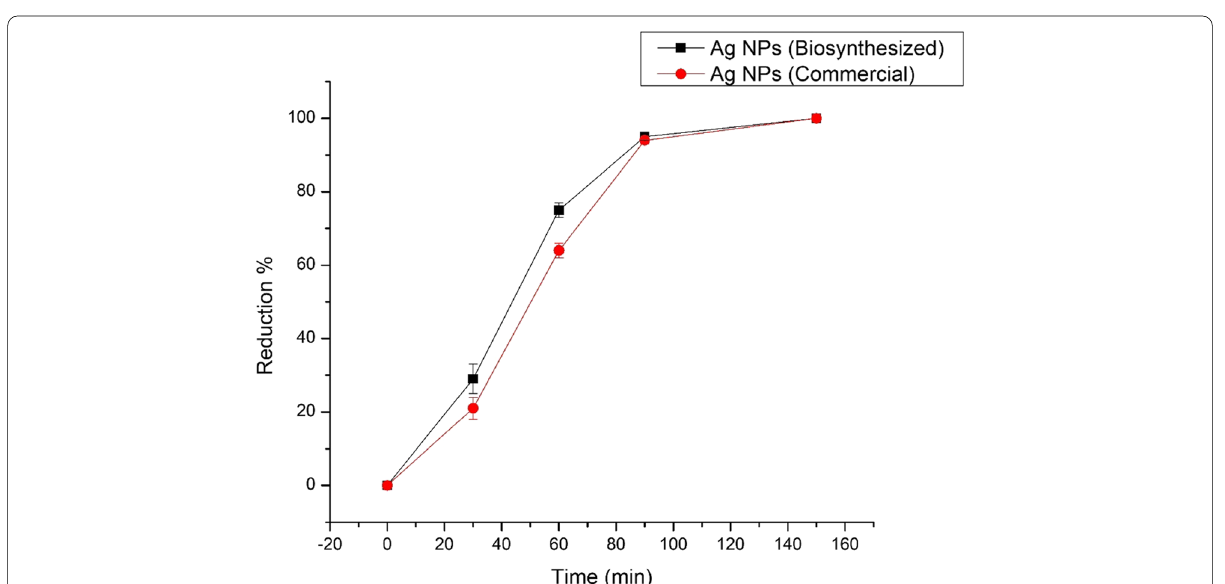
Fig. 8 The efficiency of the biosynthesized Ag NPs compared to commercial Ag NPs (ink nanosilver) in the disinfection process (the loaded concentration of each was 200